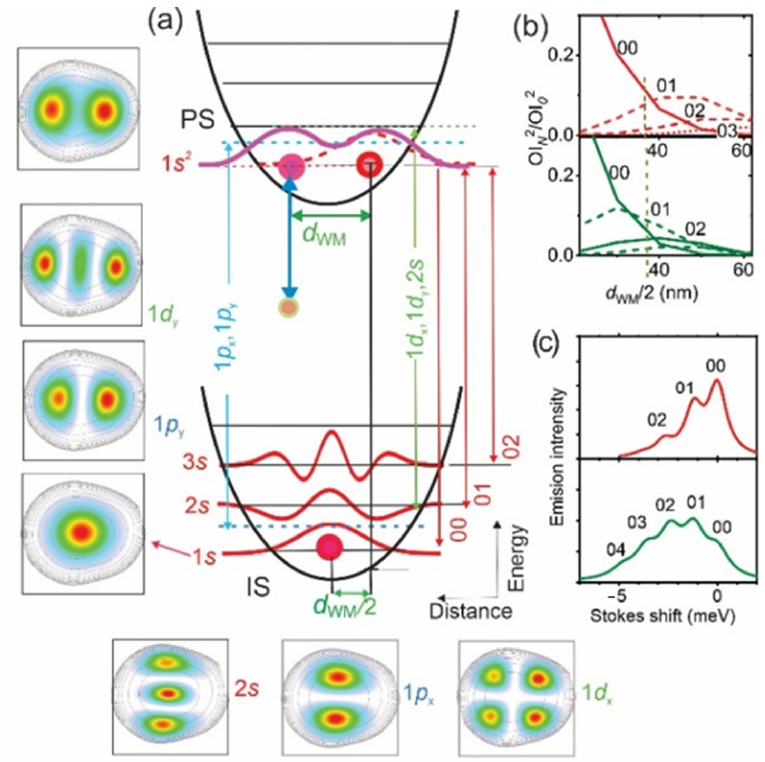
Figure 2. ( a ) Cross-sections of the parabolic confinement potential and energy levels of the initial (IS) and photo-excited (PS) state of a 1 e -QD in the Wigner localization regime ( r s = 3.8). The curves are the cross-section of the wave-functions of the corresponding energy levels and vertical arrows show a set of PL transitions involving Ns , 1 p x,y and 1 d x,y states, the electron-density distribution of which are shown on the left and lower inserts (in the 200 × 200 nm 2 frame). The thick arrow outlines a radiative recombination process and connects the photo-excited hole (smaller circle) with one of the electron (larger circles). ( b ) Square of the ratio of the overlap integrals OI N (see text) for B = 0 T ( upper ) and 7 T ( lower ). The dashed line shows the value of d WM /2 in ( a ). ( c ) PL spectra calculated using ( b ) for B = 0 T ( upper ) and 7 T ( lower